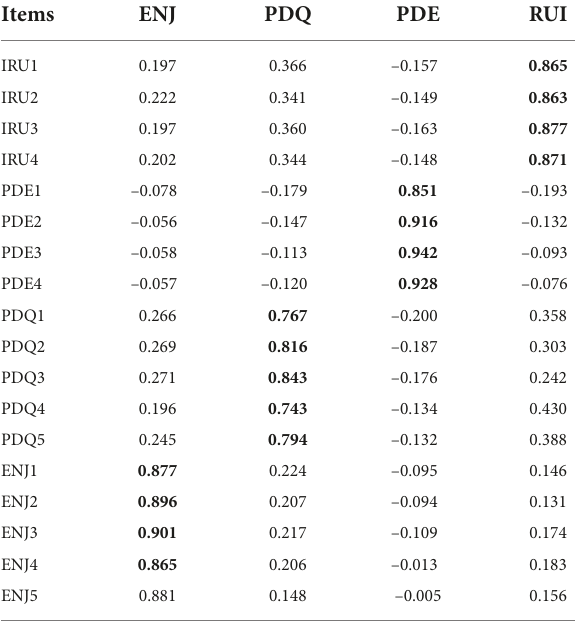
TABLE 5 Loadings and cross-loadings measures.